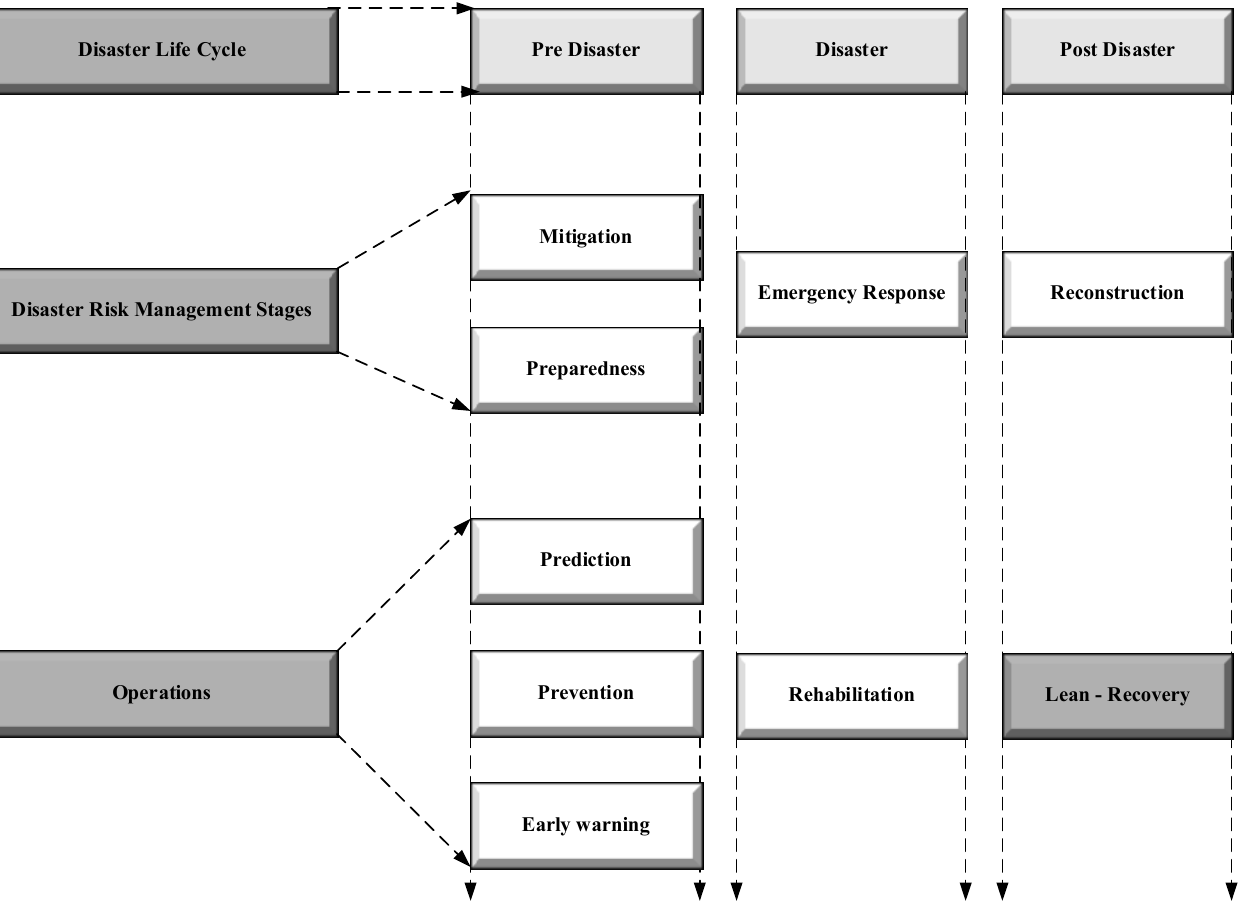
Figure 3. Lean-Recovery implementation in disaster risk management.